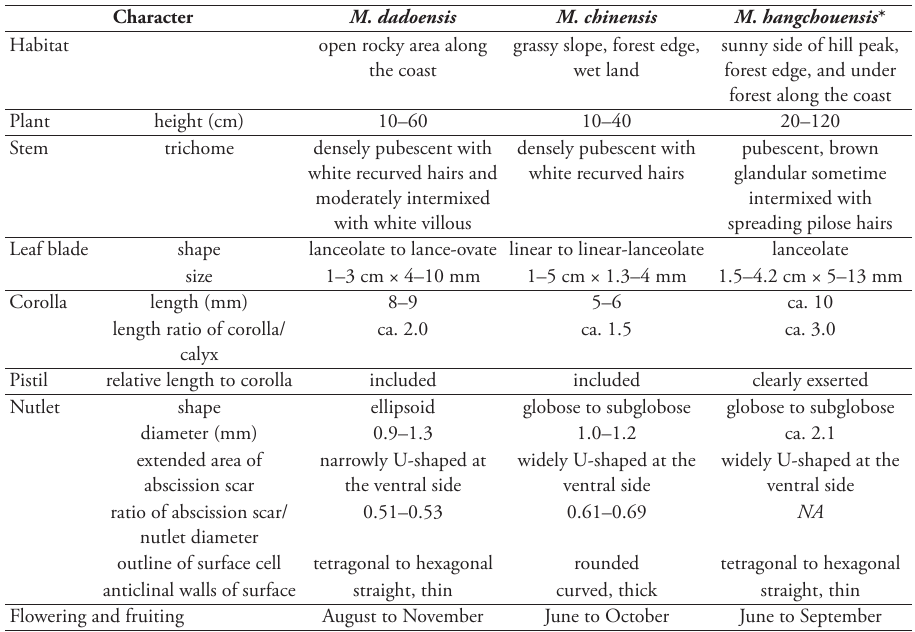
Table 3. Comparison of major characters of Mosla dadoensis , M. chinensis , and M. hangchouensis (*: data from Li and Hedge 1994; Zhou et al. 1997; Ge and Chang